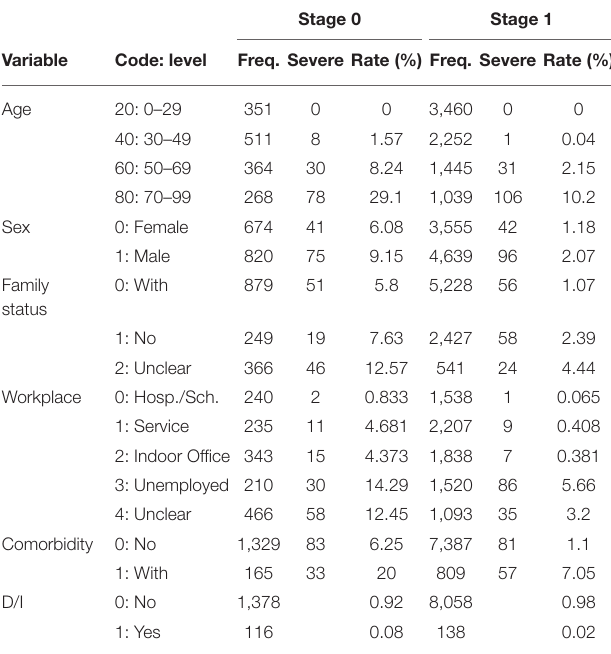
We examined associations between D/I and workplace, age, sex, family, and comorbidity by using a logistic model. It